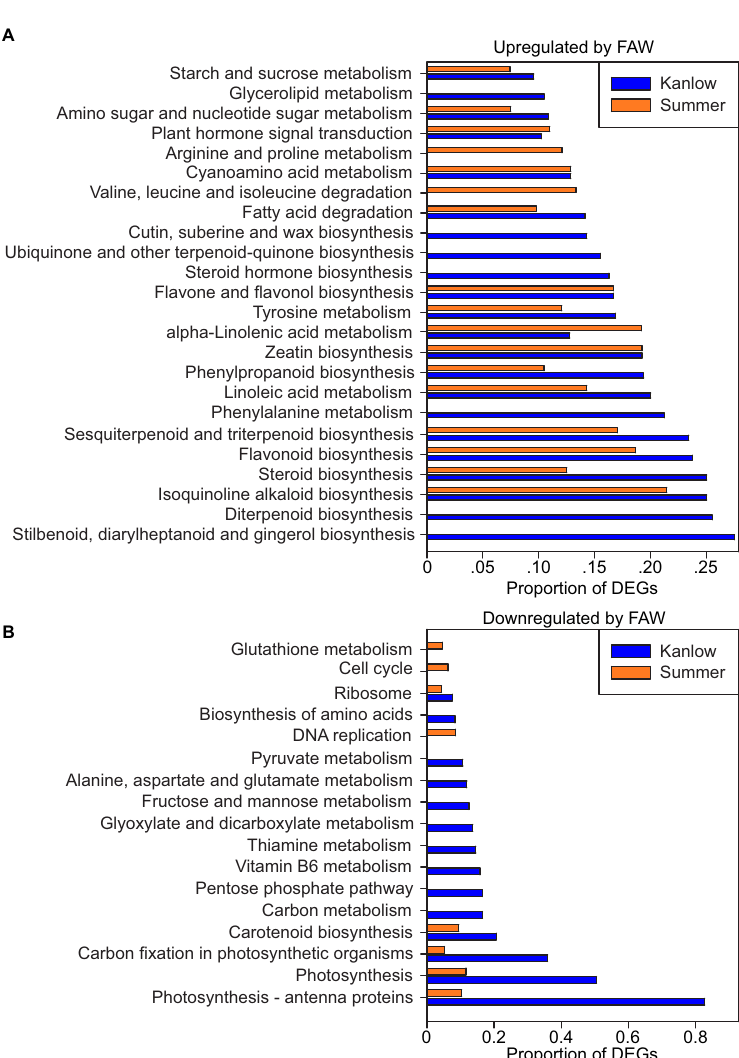
from FAW herbivory as indicated by higher larval mass for insects fed on Summer plants (see Fig 1A). Cyanoamino acid metabolism, plant hormone signal transduction, zeatin biosynthe- sis, and flavone and flavanol biosynthesis were equally represented by DEGs from both culti- vars. All of the other KEGG metabolic pathways had higher representation of DEGs derived from Kanlow plants. Although DEGs associated with sesqiterpenoid and triterpenoid biosyn- thesis were found in both cultivars, those ascribed to phenylalanine metabolism, ubiquinone and other terpenoid-quinone biosynthesis, diterpenoid biosynthesis, and stilbenoid, diarylhep- tanoid, and gingerol biosynthesis were uniquely enriched in Kanlow plants (Fig 3A). Whether, anti-feedant and/or insecticidal compounds arising from these pathways contributed to the differential feeding of FAW is not currently known. Deamination of phenylalanine to